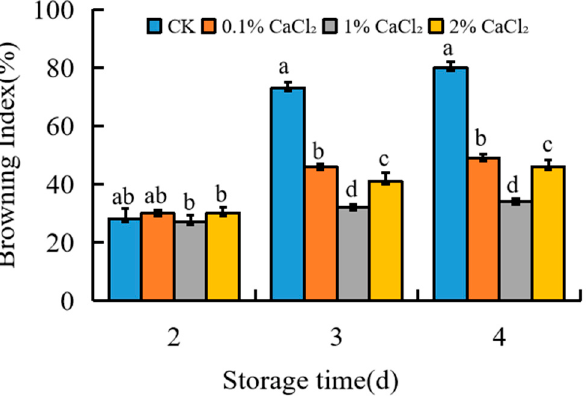
Figure 1. Effect of CaCl 2 treatment on BI of fresh-cut luffa. Each value is presented as a mean ± SE ( n = 3). Statistically significant differences ( p ≤ 0.05) are indicated by different letters above bars.